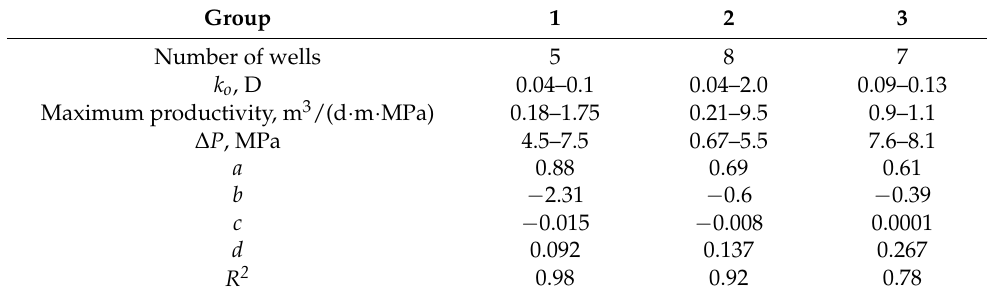
Table 1. Reservoir and production data and calculated values of coefficients for Equation (1).